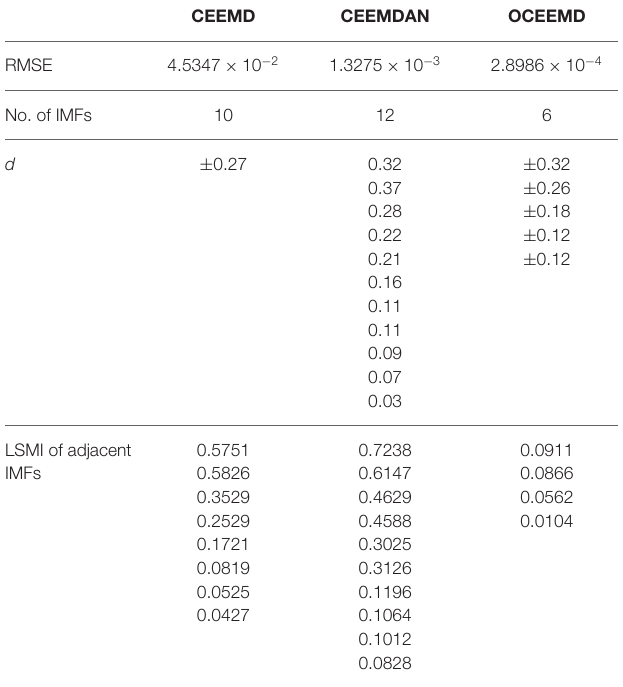
TABLE 2 | Comparison of CEEMD, CEEMDAN, and OCEEMD.